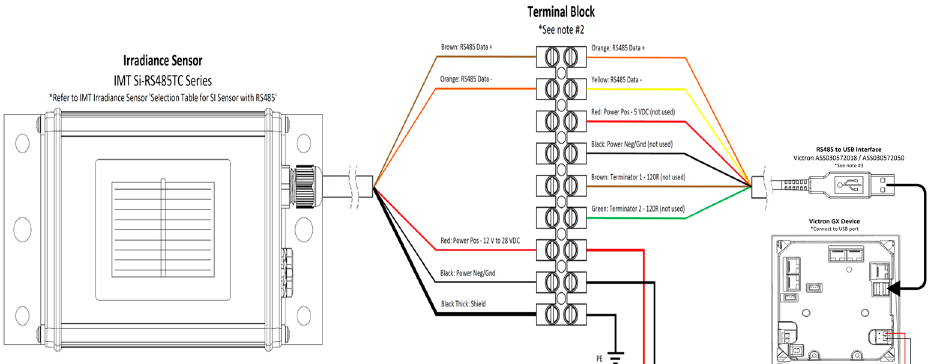
Figure 5. Installation diagram and wiring configuration on a Venus GX controller with Irradiance Sensor IMT Si ‐ RS485TC.